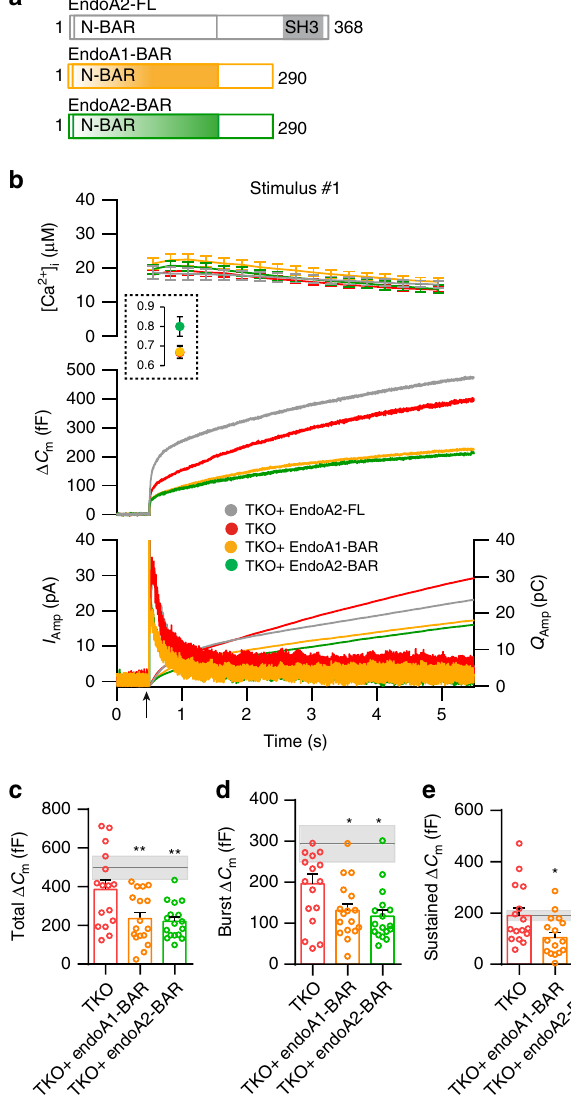
Fig. 6 Endophilin BAR-domains are not suf fi cient to mediate chromaf fi n cell exocytosis. a Schematic depicting the domain structure of endophilin 2 and two mutants lacking the SH3 domain expressed in the subsequent experiments. b Exocytosis induced by calcium uncaging in endophilin TKO chromaf fi n cells (red traces) compared to TKO cells expressing either endophilin 1 BAR domain (yellow traces), endophilin 2-BAR domain (green traces) or full-length endophilin 2 WT protein (gray traces). Panel arranged as in Fig. 1i, top: intracellular calcium level increase induced by fl ash photolysis at 0.5 s (at arrow). The inset shows the pre- fl ash calcium levels. Middle: averaged traces of membrane capacitance upon Ca 2 + -induced exocytosis. Bottom: mean amperometric current (left axis) and cumulative charge (right axis). c – e Quanti fi cation of changes in capacitance revealed a further reduction in different phases of release (burst and sustained) in TKO cells expressing endophilin 1-BAR or endophilin 2-BAR domain. Gray line indicates the mean of TKO cells expressing endophilin 2 full-length protein and the shaded area indicates the SEM. b – e N = 3, 3 mice/condition, cells TKO (16), TKO + endophilin1 BAR (17) and TKO + endophilin 2-BAR (17). Error bars denote SEM. N = number of independent replicates. One-way ANOVA with Tukey ’ s multiple comparison test, * p < 0.05, ** p <